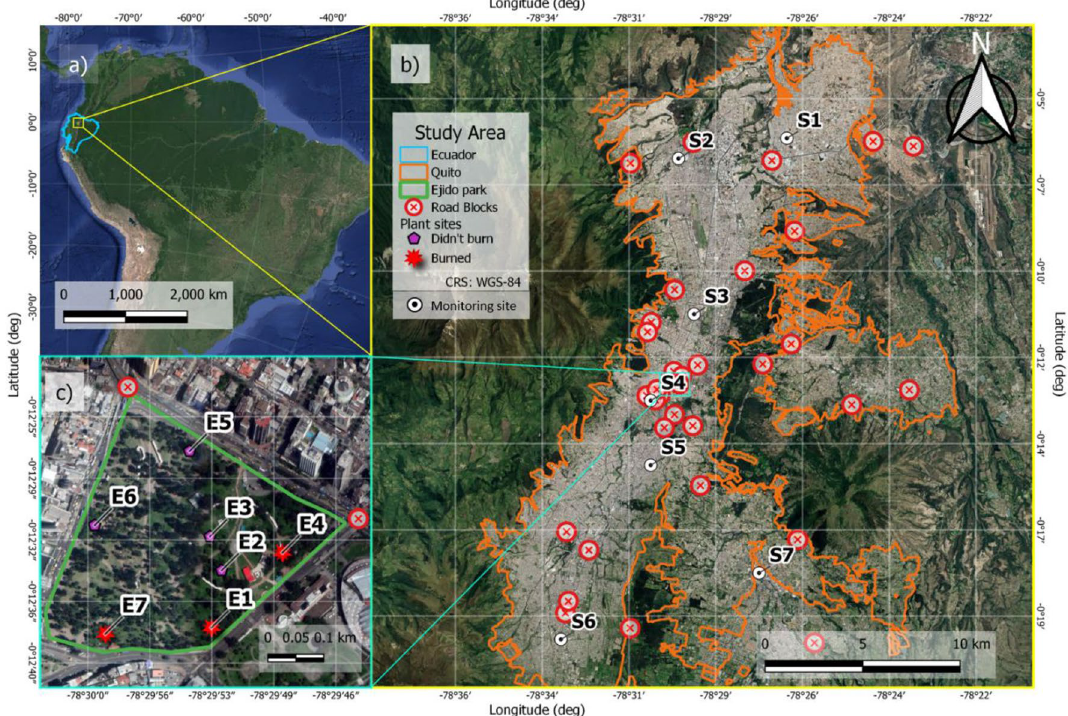
Figure 5. Study sites: ( a ) Map of the location of Ecuador in the context of South America; ( b ) Map of Quito and the selected PM 2.5 measurement sites (S1–S7) belonging to the environmental monitoring network of the Secretariat of the Environment of DMQ; and c) Melaleuca armillaris leaves’ sampling sites (E1–E7) at El Ejido Park in the hot spot of the national protest. Spatial visualization software QGIS 3.18 was used, employing ESPG 4326 (WGS 84) (panel a ) and EPSG.32717 (WGS84-UTM17 South) coordinate system (panels b , c ). Geographical Information Software QGIS 3.18.2 was used ( available at https:// qgis. org/ downl oads/), employing ESPG 4326 (WGS 84) (panels a – c ), Ecuador limits were retrieved from Geographic Military Institute (retrieved from https:// sni. gob. ec/ geose rvici os- ecuad or), Urban Growth of Quito was used for Quito limits (retrieved from http:// gobie rnoab ierto. quito. gob. ec/? page_ id= 1122), Quito’s monitoring sites were retrieved from Secretaría de Ambiente from Quito (http:// www. quito ambie nte. gob. ec/ index. php/ gener alida des), Road blocks were retrieved from Rcuadorian newscasts (available at https:// www. primi cias. ec/ notic ias/ socie dad/ quito- manif estac iones- vias/ and ) and Satellite image was used from XYZ Tiles service from Google (available at http://mt0.google.